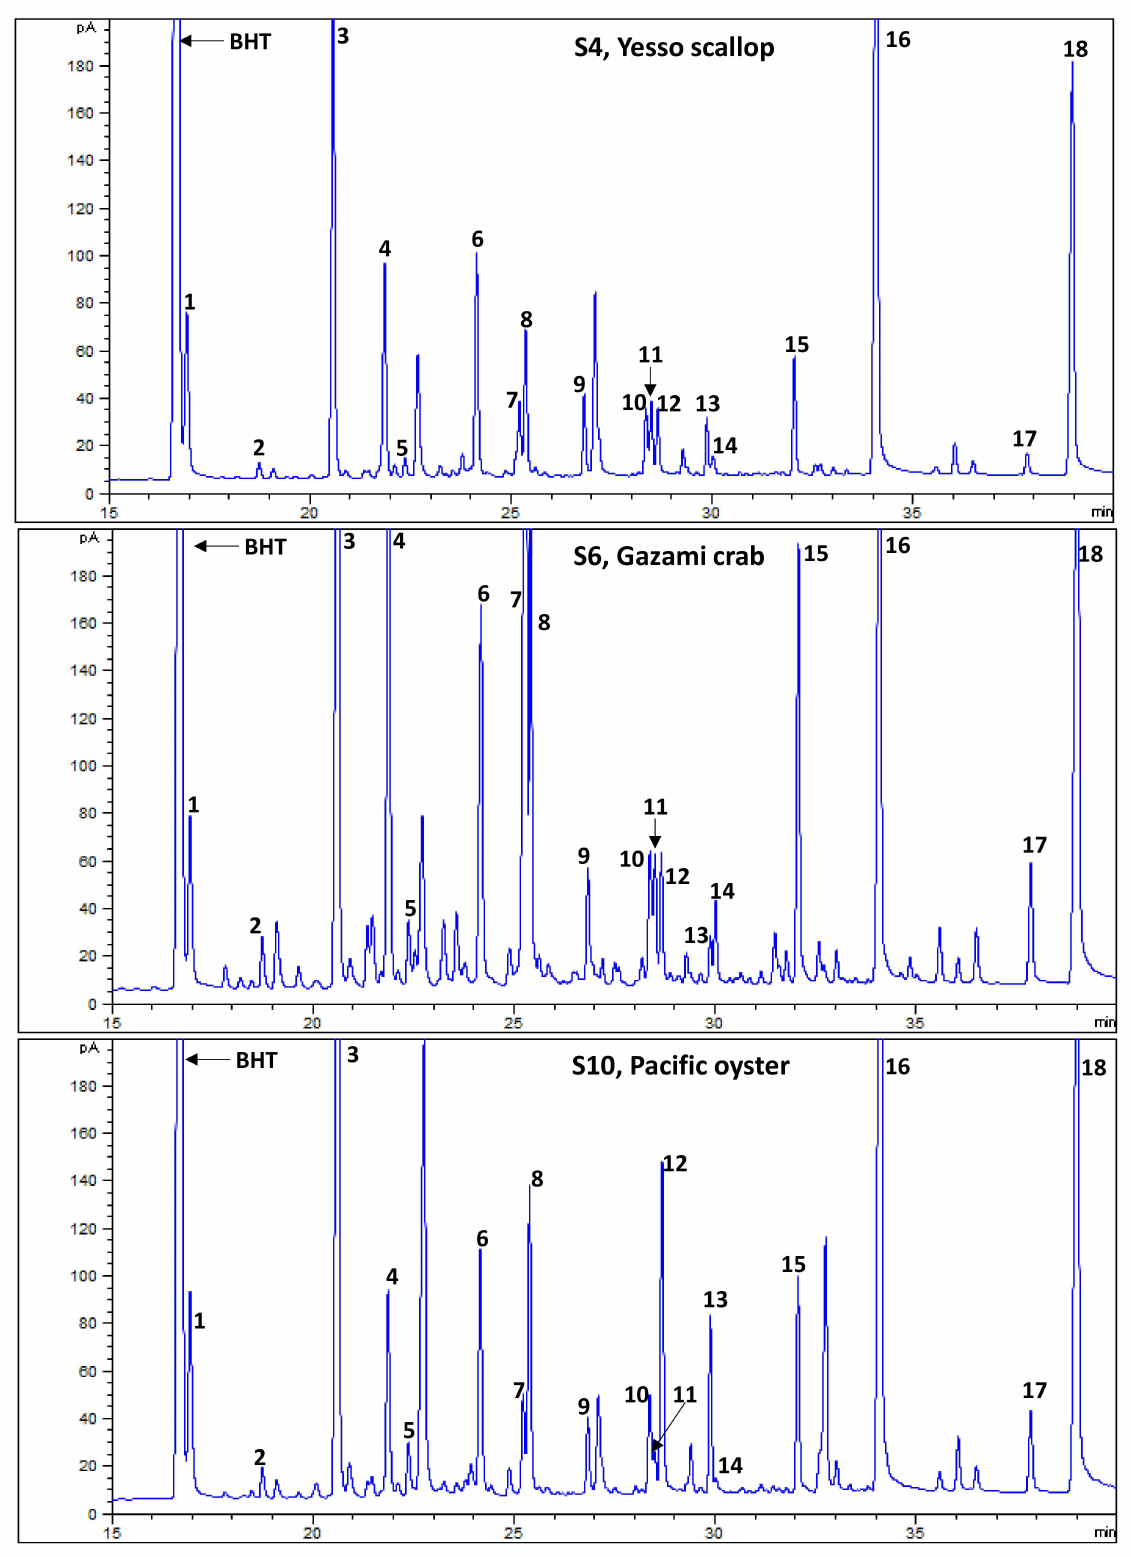
Figure 4. The representative gas chromatography (GC) flame ionization detection (FID) chromatograms of fatty acids and methyl esters (FAMEs) of the Yesso scallop, Gazami crab, and oyster. The peak numbers (1 to 18) correspond to Table